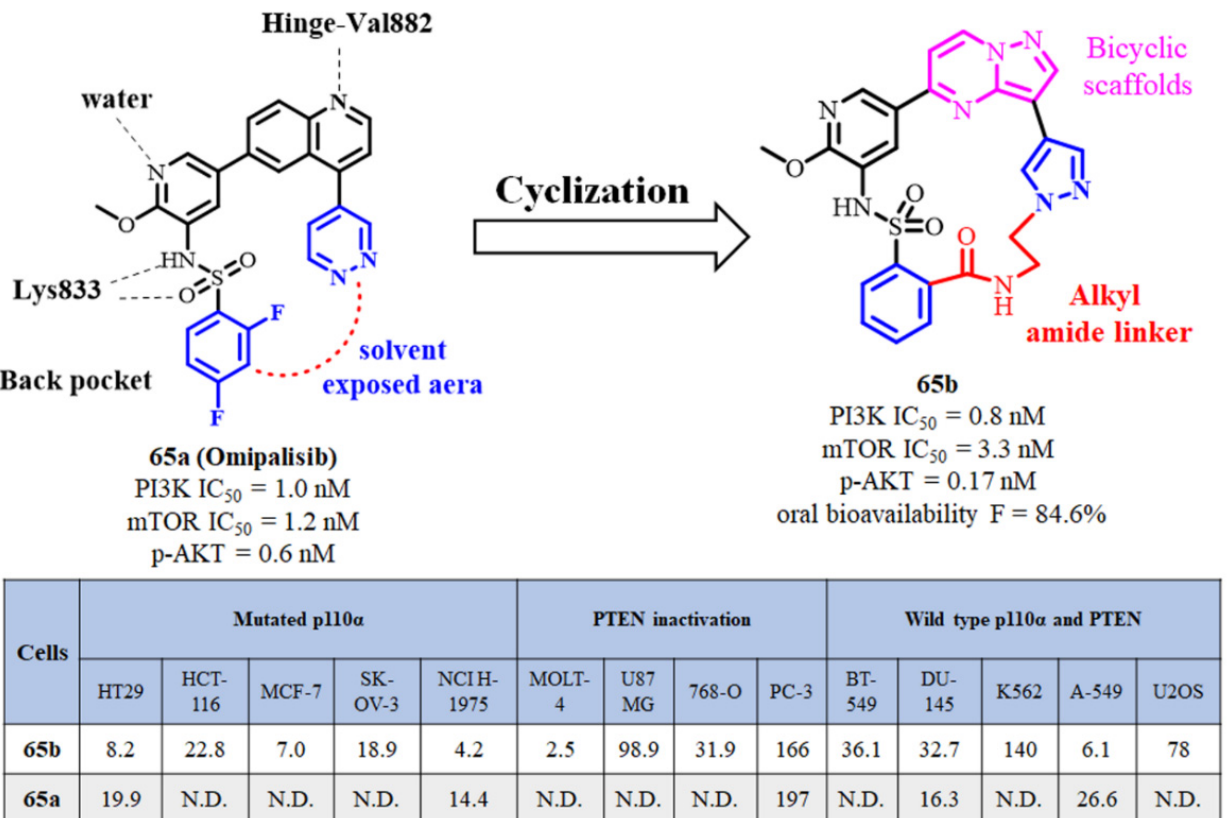
Figure 22. Schematic representation of the rational design of dual PI3K/mTOR macrocyclic inhibitors. Growth inhibition 50 (GI 50 ) against cancer cells of compound 65b in vitro.